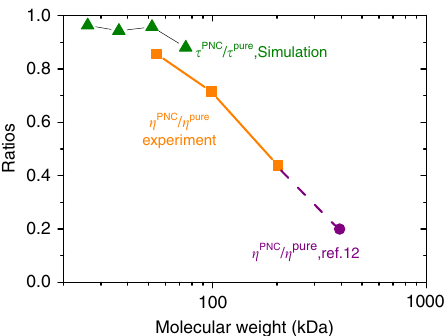
Fig. 5 The relative viscosity η PNC = η pure for the systems with different PS molecular weight at a fi xed NP loading of 2 % at T = 170 (cid:7) C, η PNC and η pure are the viscosities of PNC and pure PS melt systems respectively. NP has a molecular weight of 26.2 kDa. The last data point in purple is taken from ref. 12 , where NP loading is 1% and SCNP has a molecular weight of 25 kDa. Triangles are the ratio between effective terminal relaxation times for composite systems with a SCNP loading of 2% and that of the pure melt, this ratio is taken from Fig. 4a at p = p